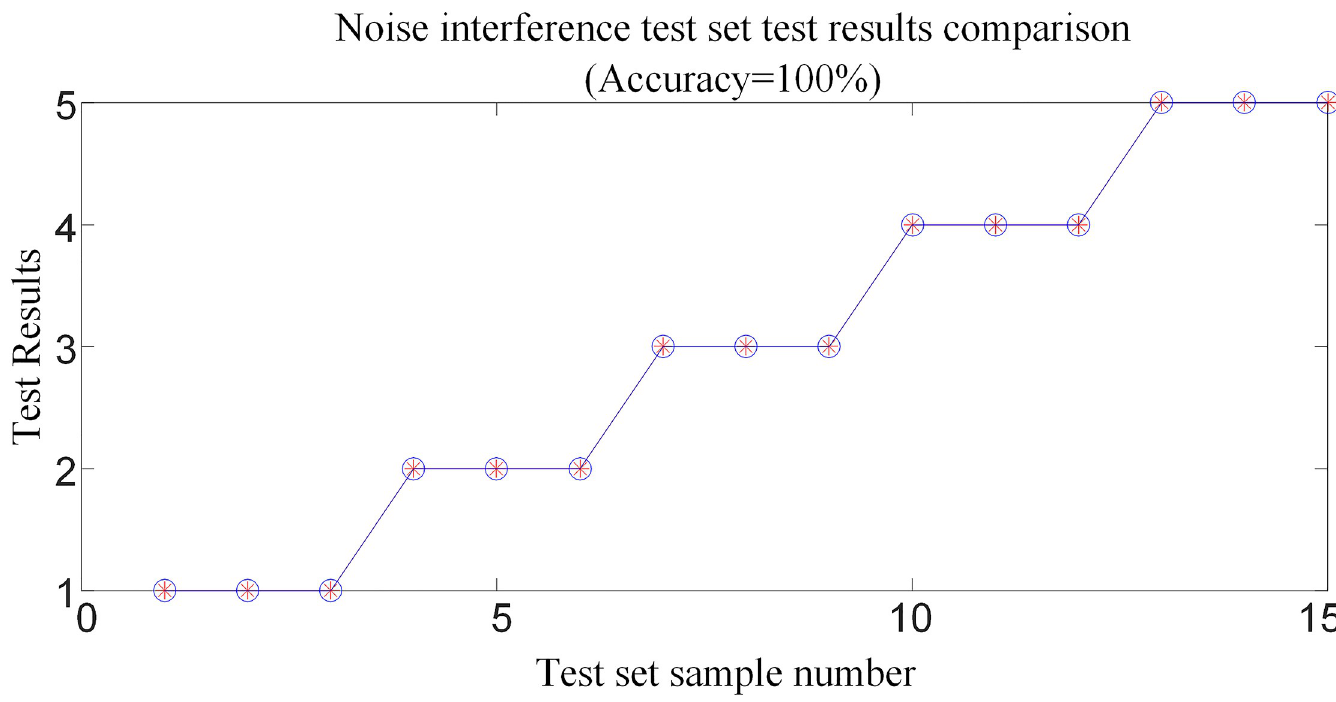
Fig 22. 30~50dB noise interference test results.